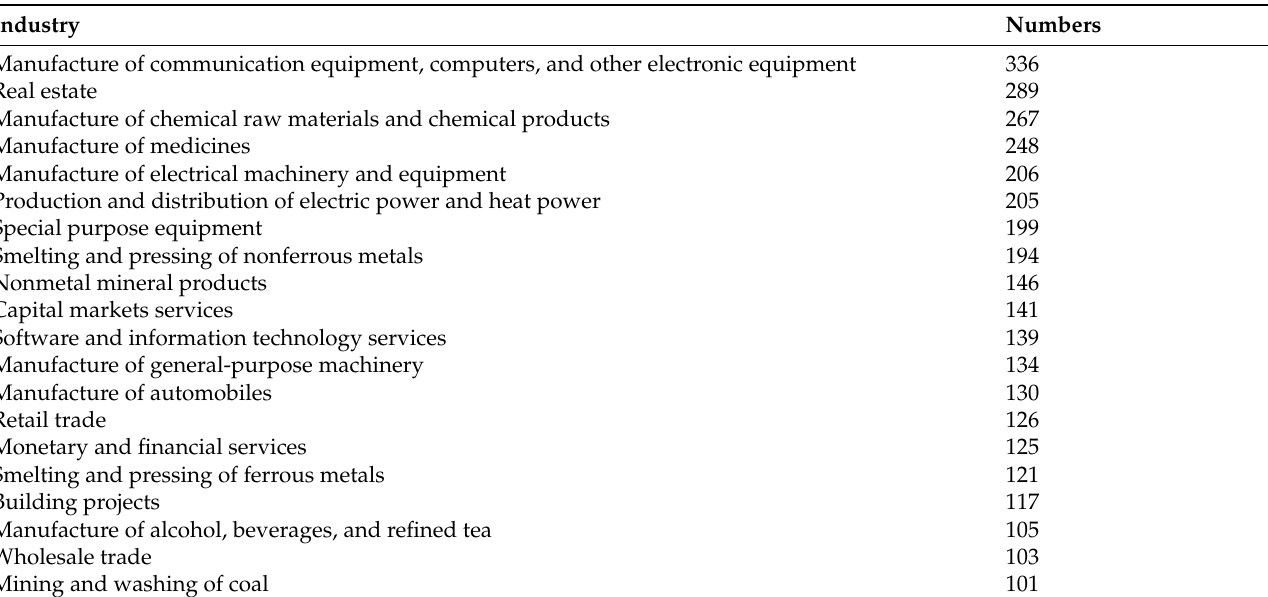
Table 2. Industry distribution of firms (the top 20